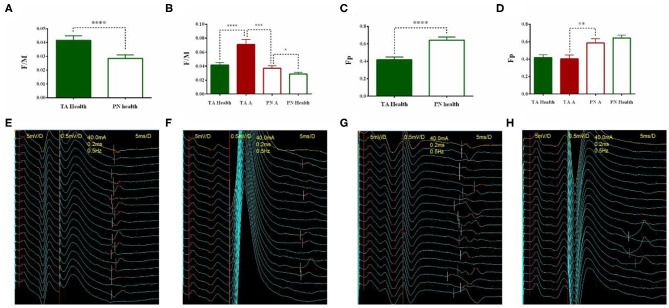
The natural difference of F wave between TA and PN and the change after stroke. The natural differences of F/M between TA and PN in healthy controls (A). The F/M of TA and PN of the affected side increased significantly after stroke (B). The natural differences of Fp between TA and PN in healthy controls (C). The Fp of both TA and PN remained unchanged after stroke (D). Typical image of F wave examination of PN (E, high Fp, low F/M) and TA (F, low Fp, high F/M) in healthy group, and PN (G, F/M increased significantly while Fp unchanged) and TA (H, F/M increased significantly while Fp unchanged) in stroke patients (*p < 0.05, **p < 0.01, ***p < 0.001, ****p < 0.0001; error bar:1 SEM).